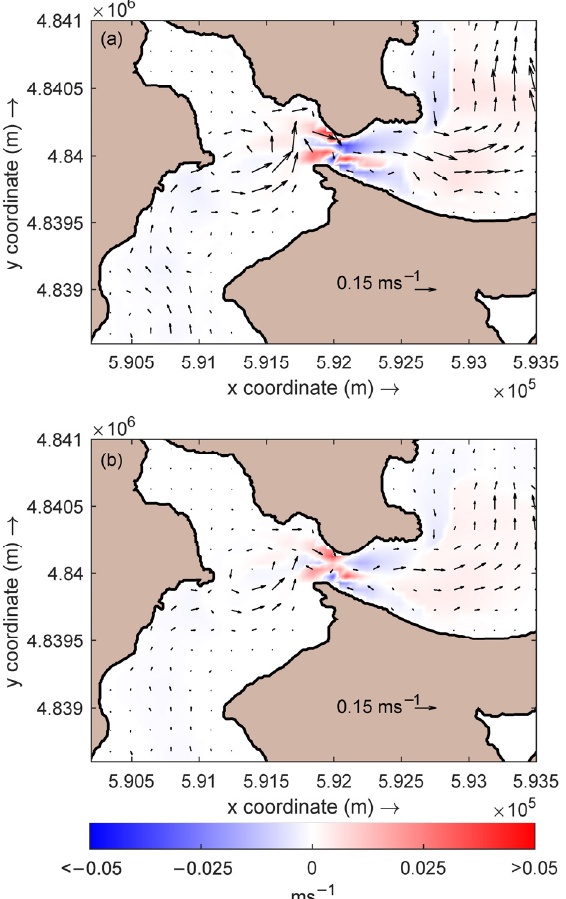
Figure 10. Residual flow pattern in Ria de Ortigueira under case study CS5 conditions (vectors); differences in the residual flow magnitude between altered flow and reference situation (CS5–CS2) (colour map). ( a ) Surface layer; ( b ) bottom layer.